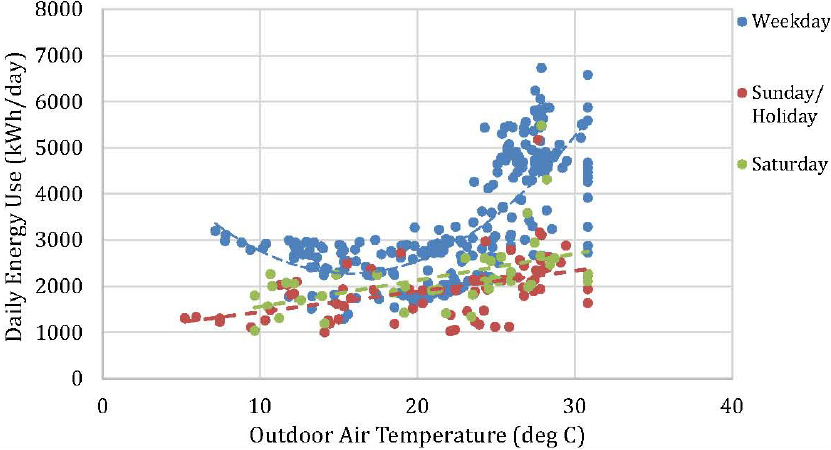
Figure 12. Building energy use and outside air